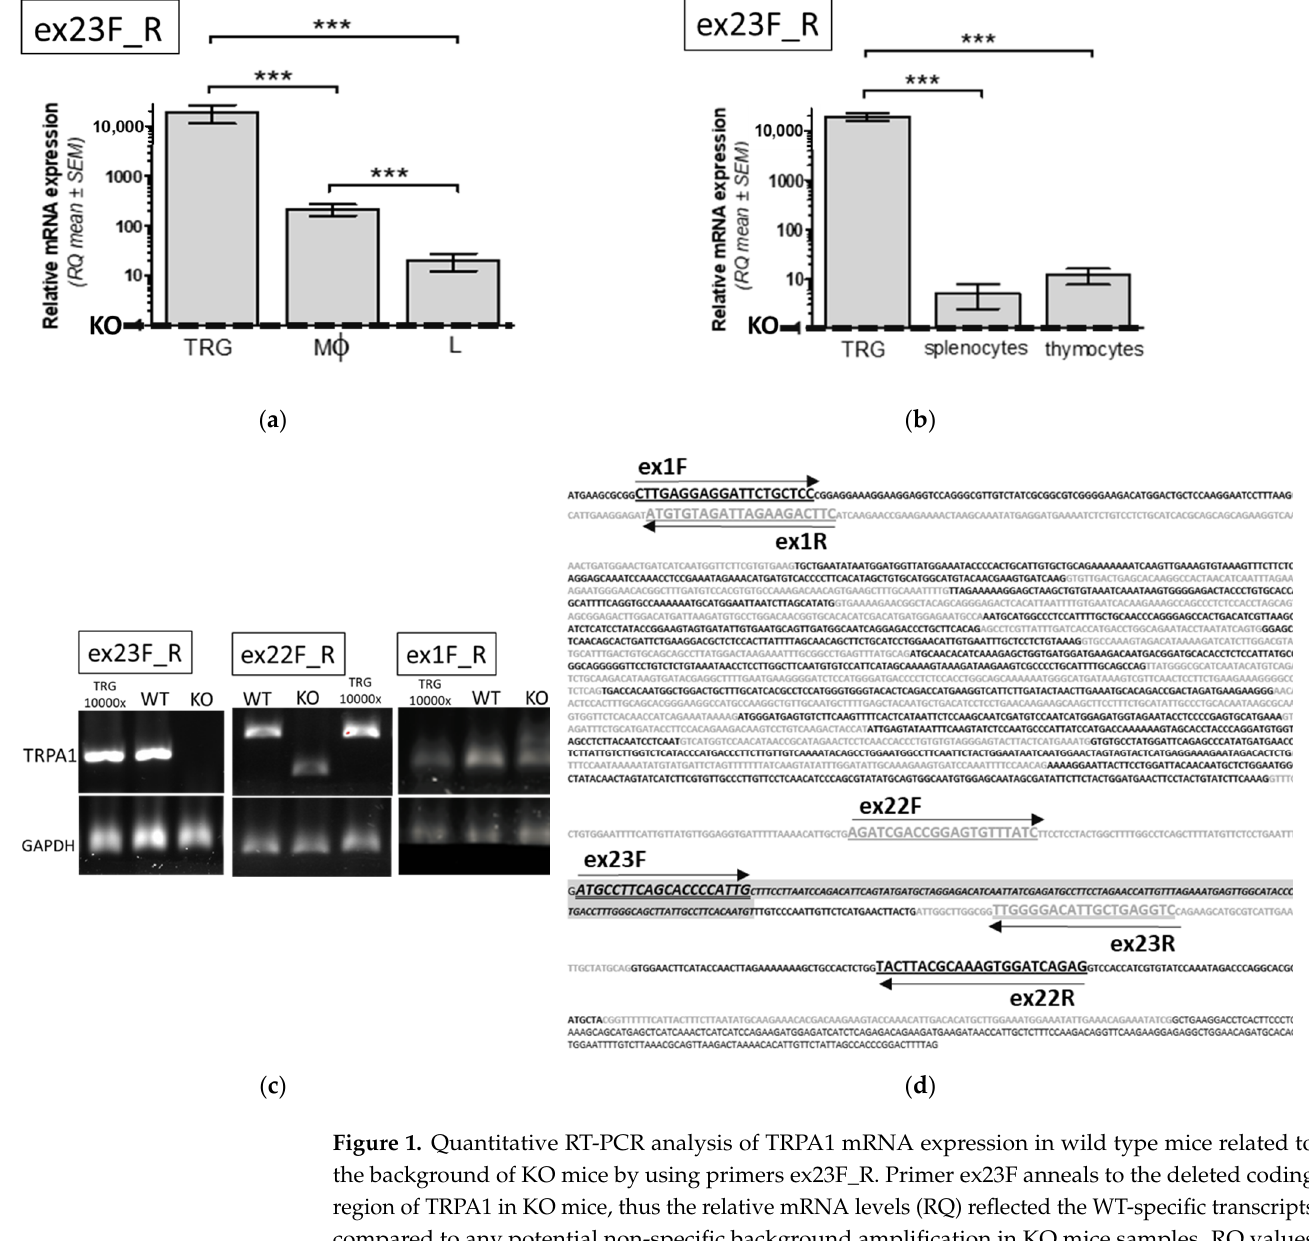
Figure 1. Quantitative RT-PCR analysis of TRPA1 mRNA expression in wild type mice related to the background of KO mice by using primers ex23F_R. Primer ex23F anneals to the deleted coding region of TRPA1 in KO mice, thus the relative mRNA levels (RQ) reflected the WT-specific transcripts compared to any potential non-specific background amplification in KO mice samples. RQ values are shown of ( a ) macrophage (M φ ) and lymphocyte (L) cell fractions isolated from peripheral blood mononuclear cells or ( b ) peripheral mononuclear cells isolated from spleen or thymus as compared to RNA expression in trigeminal ganglion cells (TRG). Fold changes (RQ) were calculated according to 2- ∆∆ Ct methods, referenced to the non-specific background amplification in KO mice, comparing amplification from RNA samples ( ∆ C, normalized by GAPDH) of the WT mice and from RNA samples of the KO mice. Data are presented as mean ± SEM, ( a ) n = 4, ( b ) n = 6, *** p < 0.01. ( c ) Representative end point RT-PCR results by using three sets of primers depicted by arrows and names in ( d ). Mouse TRPA1 coding region with exon boundaries indicated by alternating black and grey type. Highlighted grey box indicates the deleted exon 23 region in KO mice that eliminates the pore-loop and most of the sixth transmembrane domain. Primer ex23F anneals to the deleted coding region, thus specific transcripts can only be detected in the WT immune cells by ex23F_R. By using primers ex22F_R resulted amplicons with different sizes in WT and KO cells. Primers ex1F_R used to amplify the first exon region generated a PCR product with RNA of TRG and M φ from TRPA1 WT or KO